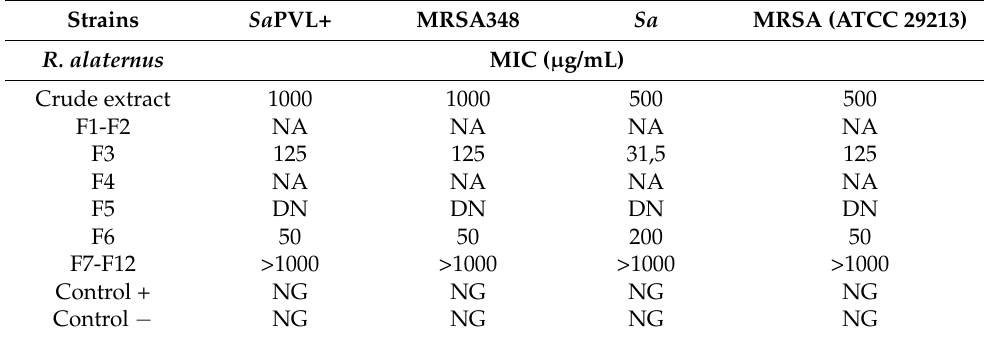
Table 3. Minimum inhibitory concentrations of R. alaternus fractions against the four strains of S. aureus . Strains Sa PVL+ R. alaternus